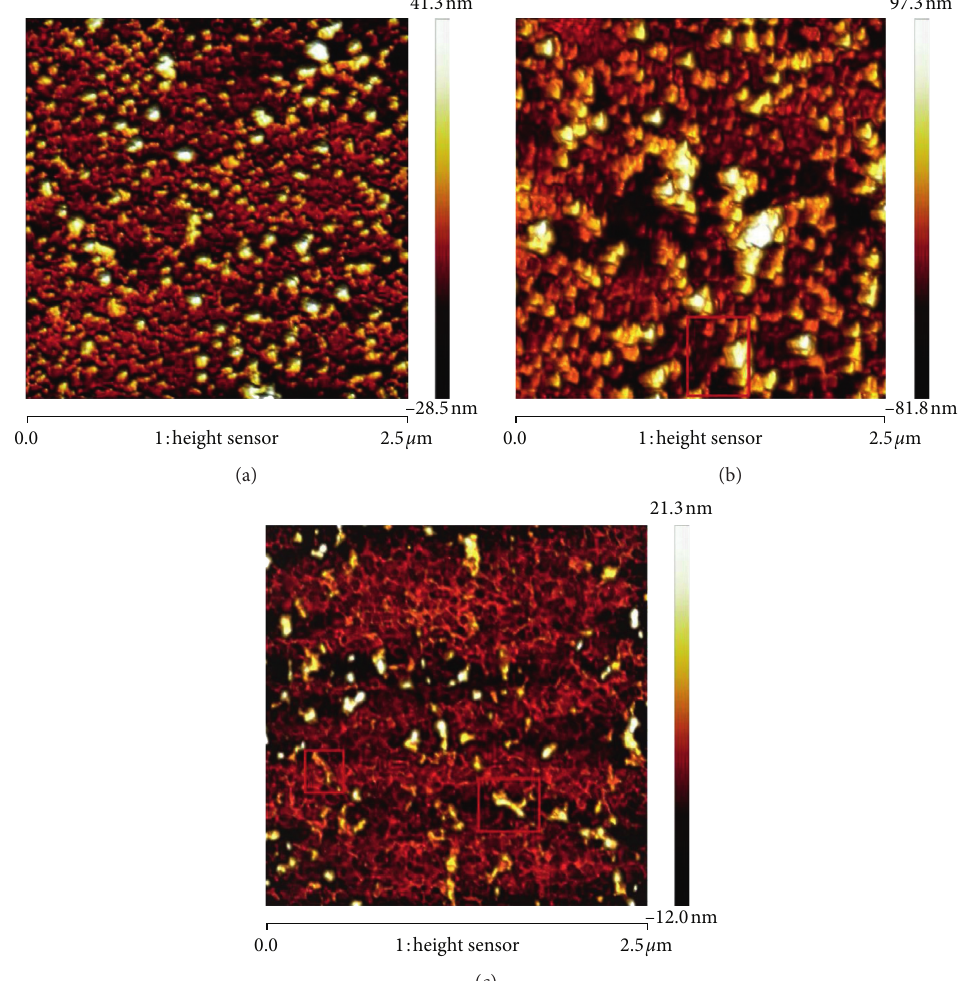
Figure 3: AFM micrographs of nanofibrils in SPI solution: (a) SPI, 0 h; (b) SPIN, 8h; (c) SPIHN, 8